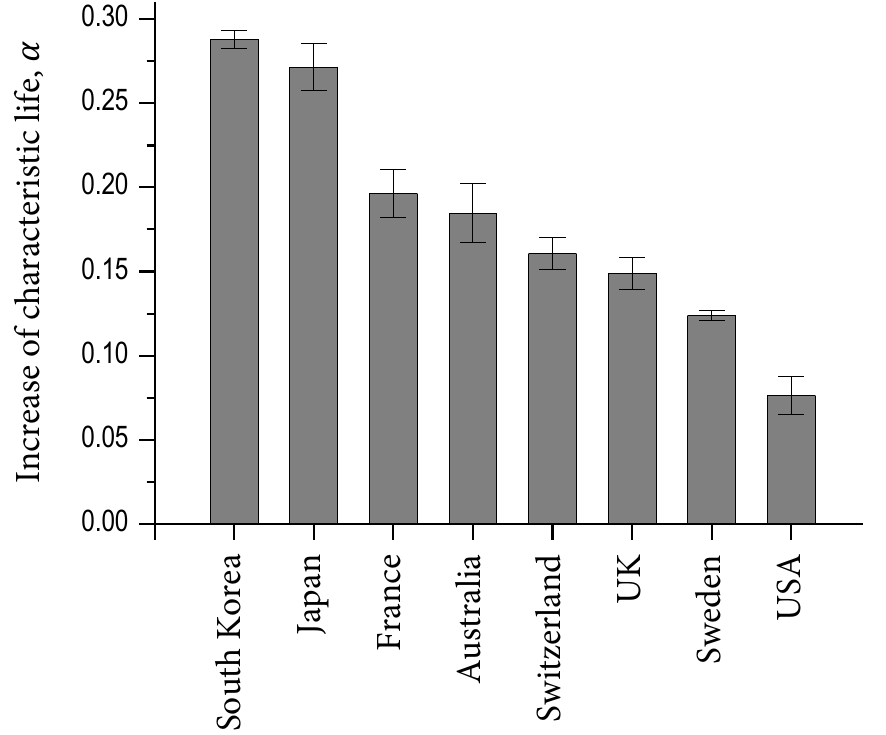
Figure 2. Comparison in the increase rate of the characteristic life per decade among representative industrialized countries. The data were taken for South Korea (1987–2016) from the Korean Statistical Information Service (http://kosis.kr/eng) and for other countries (1980–2010) from the Human Mortality Database